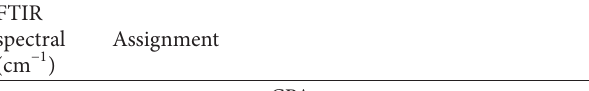
T 3: Characteristic absorption bands of CPA and CTA.